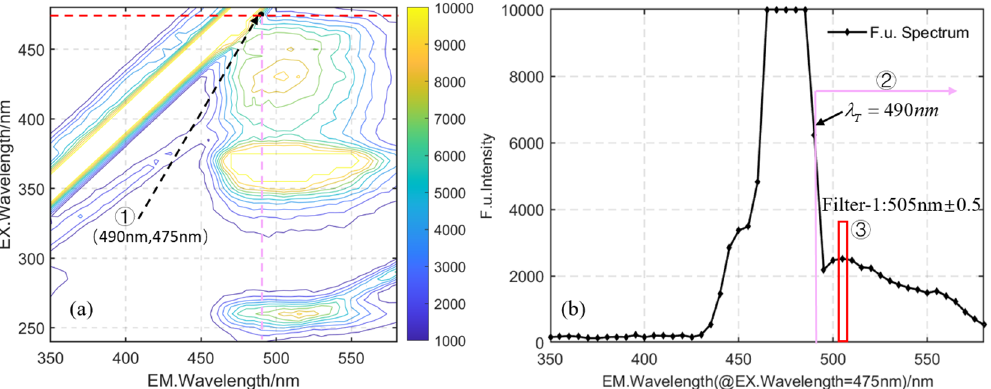
Figure 4. ( a ) 3D fluorescence scanning spectra of lucigenin (scanned range: 240–480 nm). ( b ) Luci- genin’s emission curve under an excitation wavelength of 475 nm.